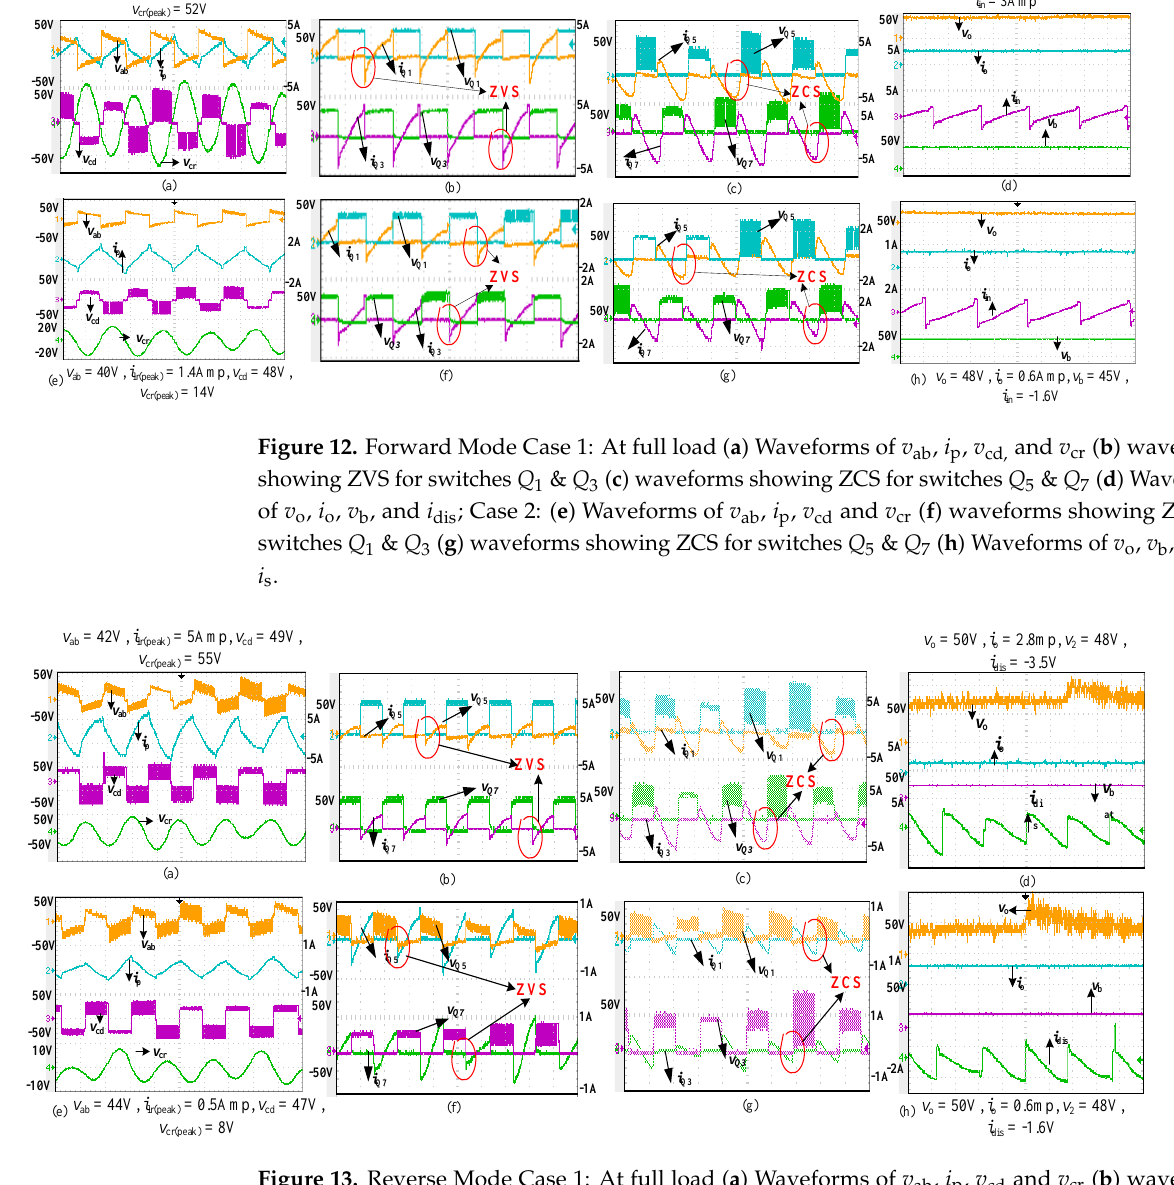
the same order at 10% of full load. The reverse mode of operation waveforms are shown in Figure 13. Case 1 (10% of full load): Square waveforms v ab & v cd with an input voltage V 2 = 48 V and an output voltage V o = 42.5 V are shown in Figure 13a along with the primary current i p and resonant capacitor voltage v cr . The waveforms showing ZVS for the switches ( Q 5 to Q 8 ) on the primary side in the reverse mode of operation through complementary switches are shown in Figure 13b. The ZCS for the secondary side switches ( Q 1 to Q 4 ) is shown in Figure 13c through the voltage and current waveforms of switches Q 1 and Q 4 . The output voltage, load current and input current or discharge current in the reverse mode of operation are shown in Figure 13d. Case 2 (10% of full load): As mentioned above in the reverse mode of operation, the waveforms are shown in Figure 13e–h in the same order for 10% of the full load.